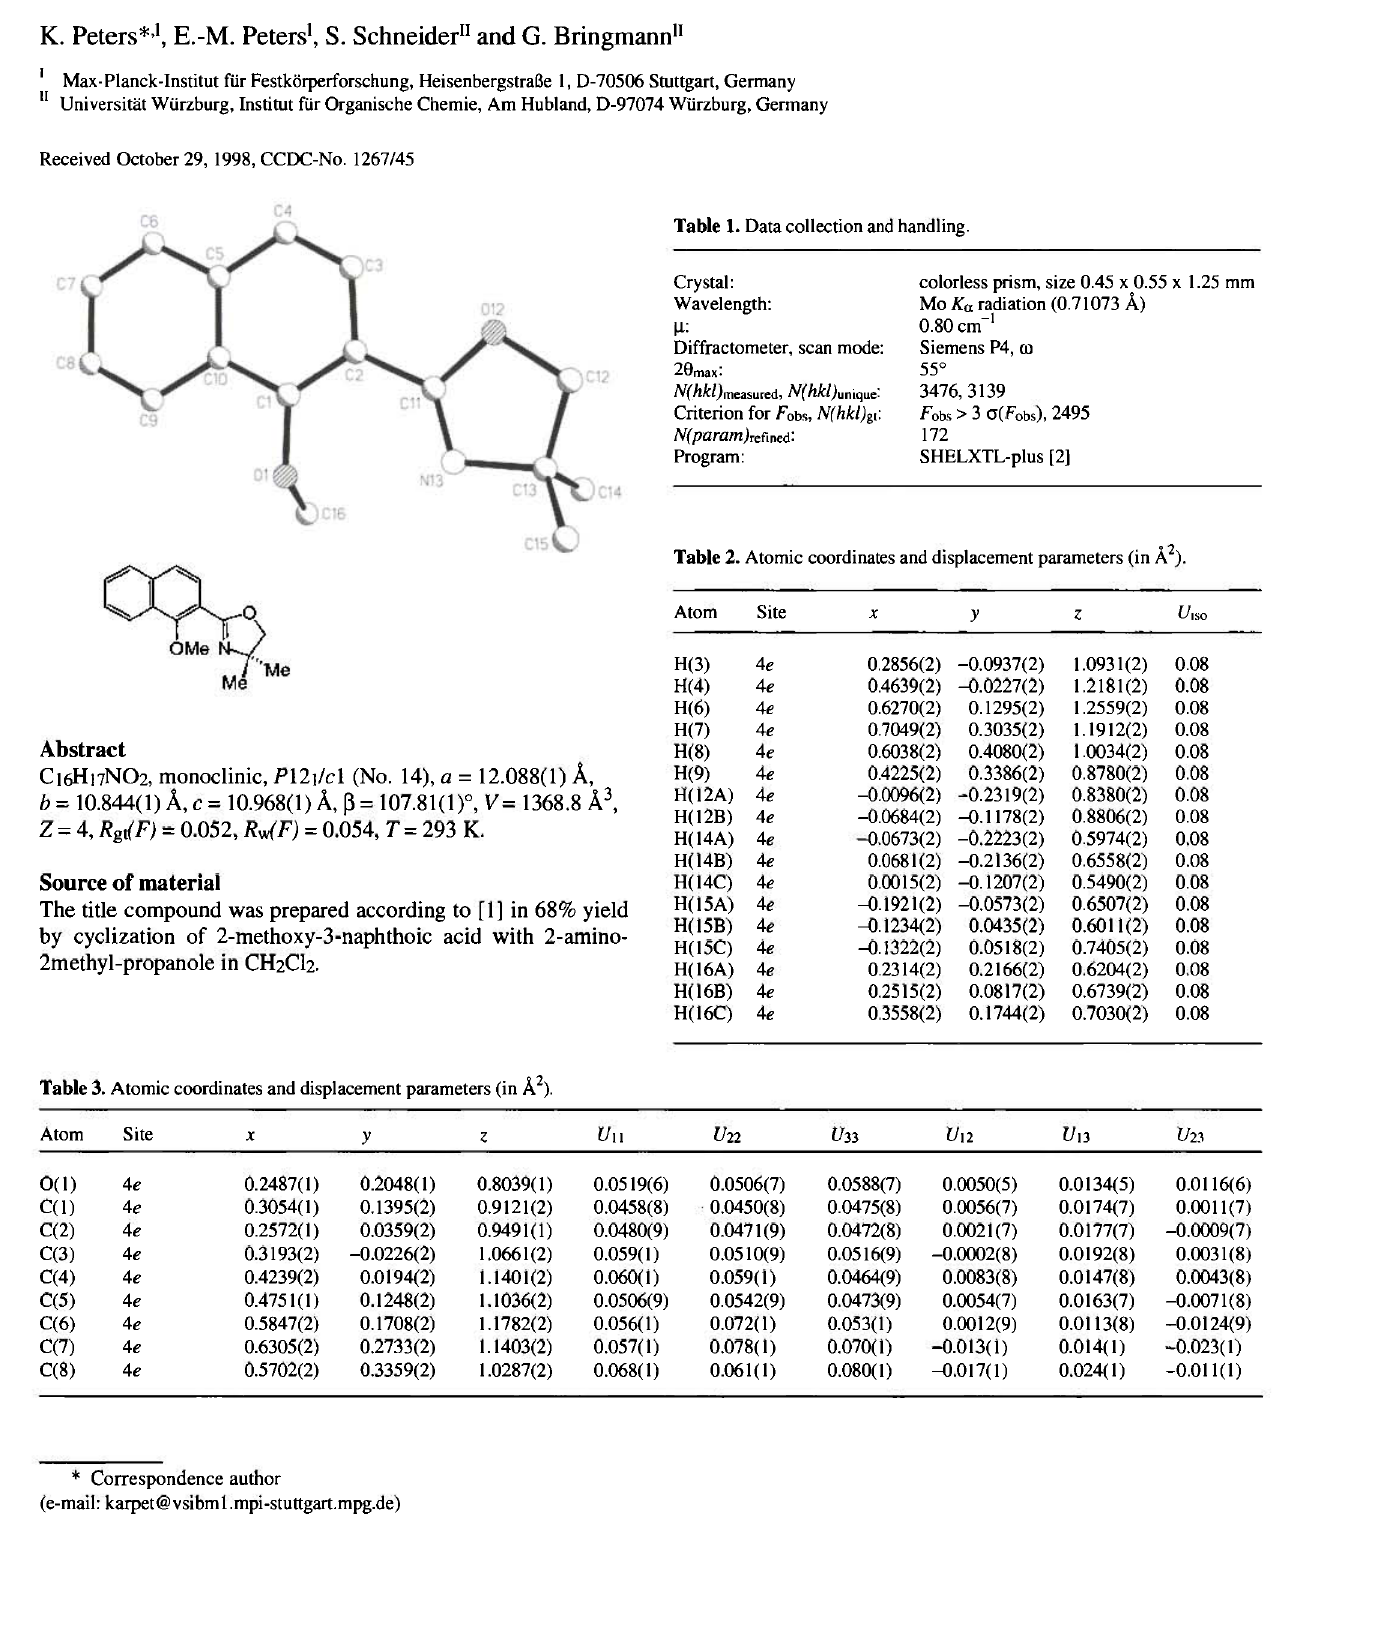
Table 1. Data collection and handling.